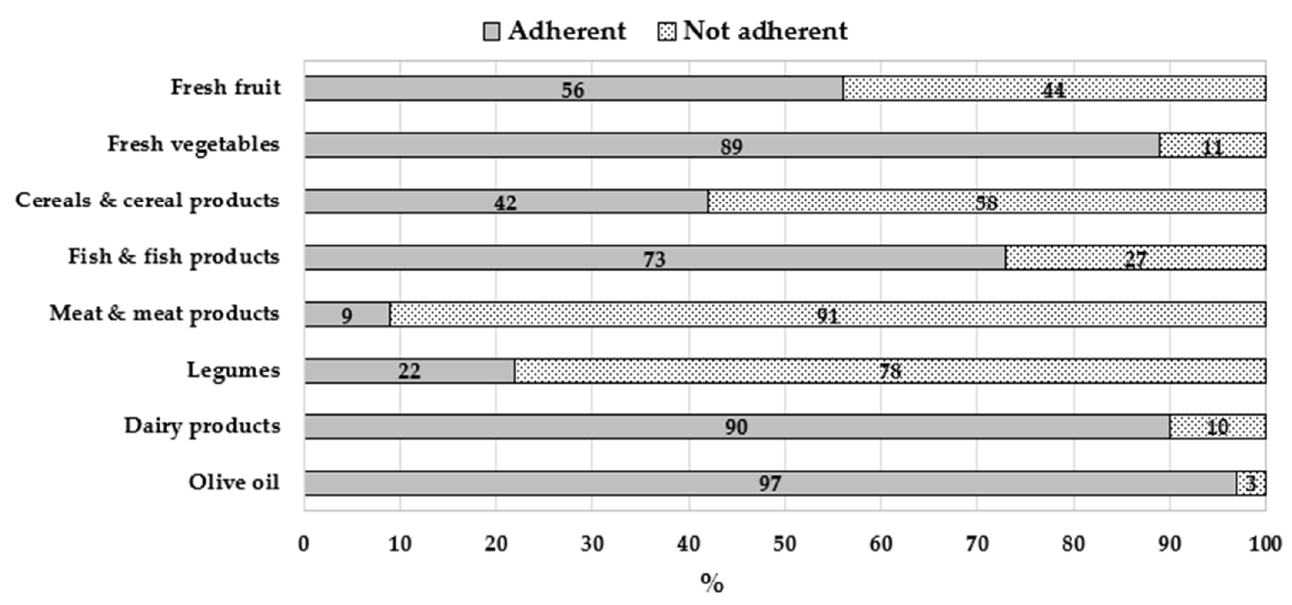
Figure 3. Percentages of individuals following a healthy sustainable diet [21] by food groups, cal- culated with the MedQ-Sus